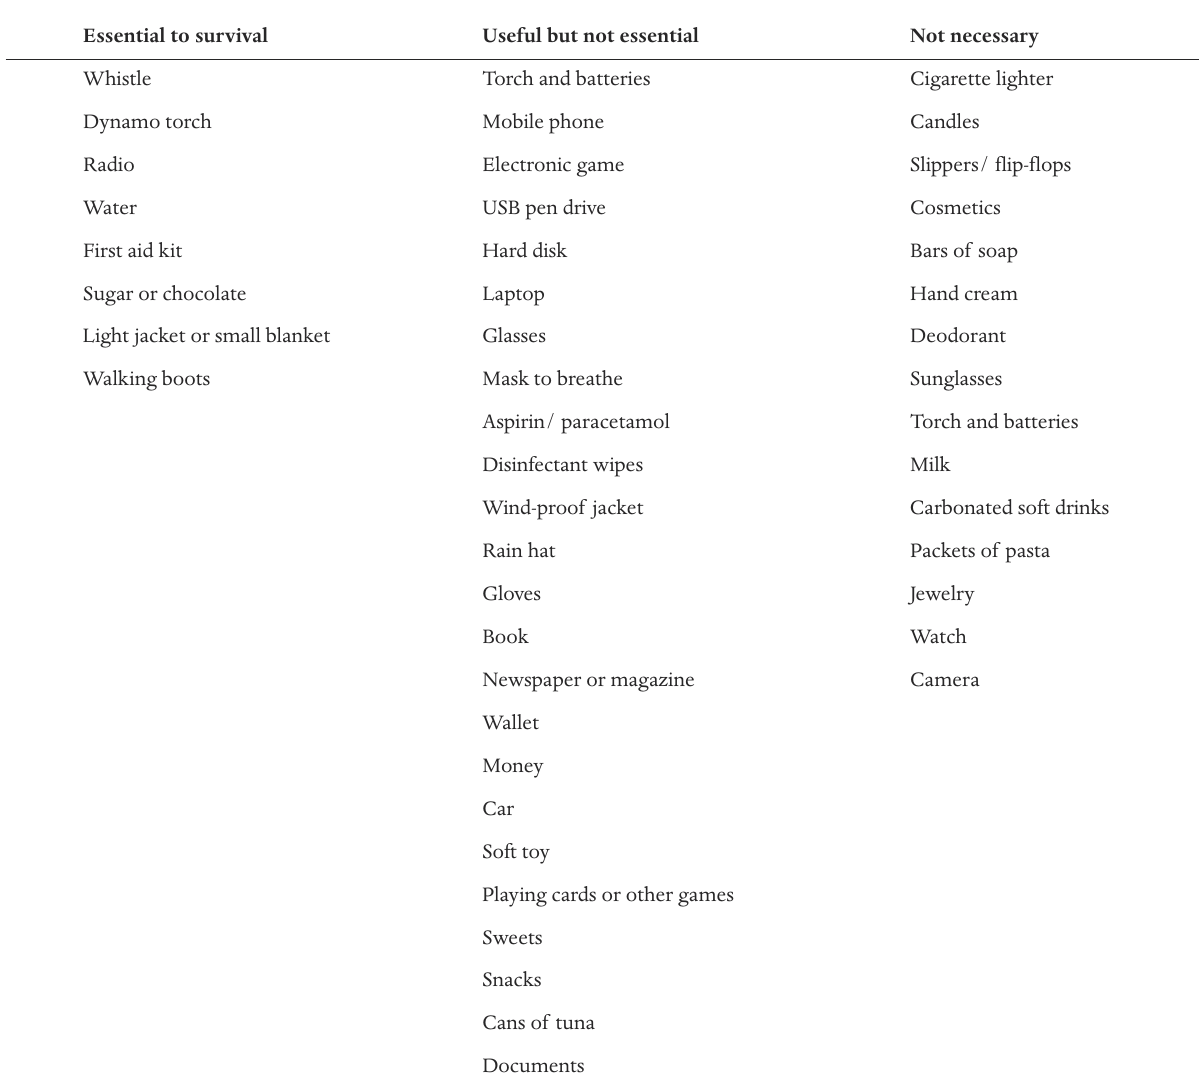
Table 2. Objects to choose from in the case of an